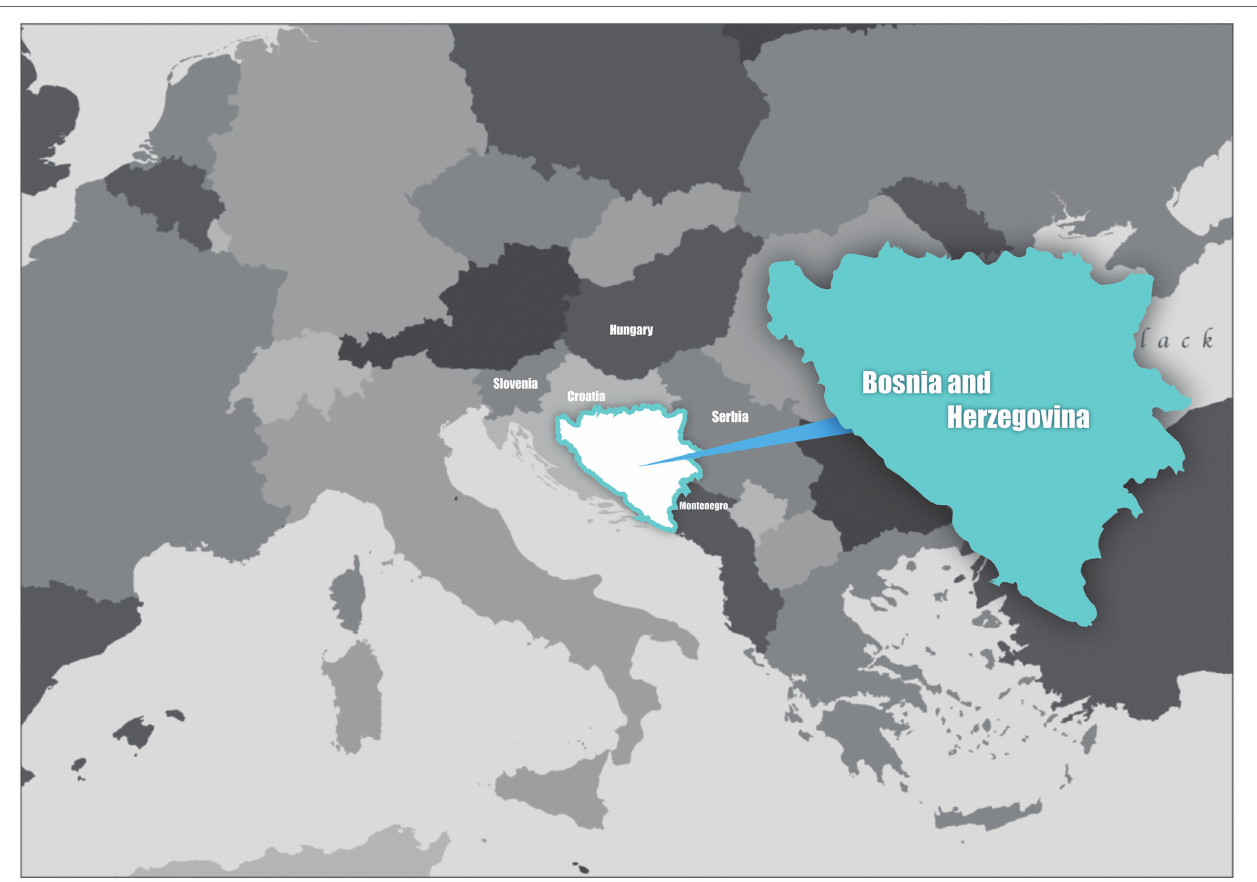
FIGURE 1 | Geographical position of Bosnia and